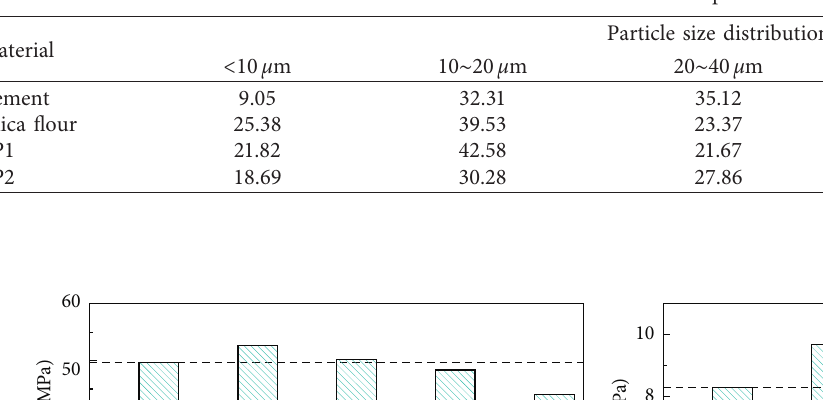
Table 4: Particle size distributions of different powder materials (%).